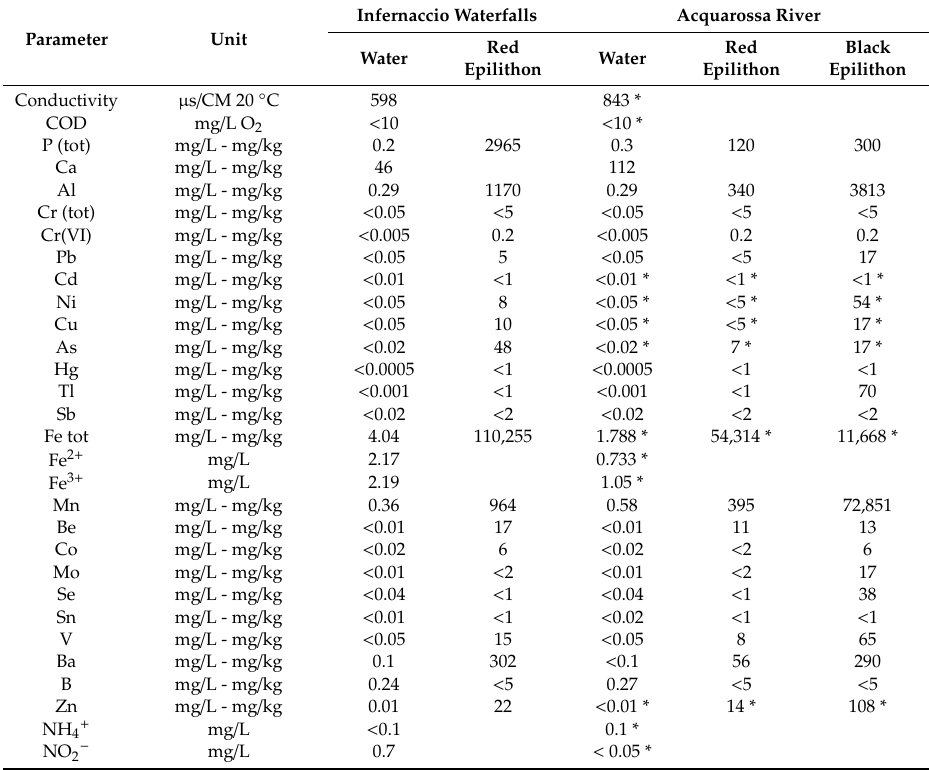
Table 1. Chemico-physical characterization of water and red epilithon from Inferaccio